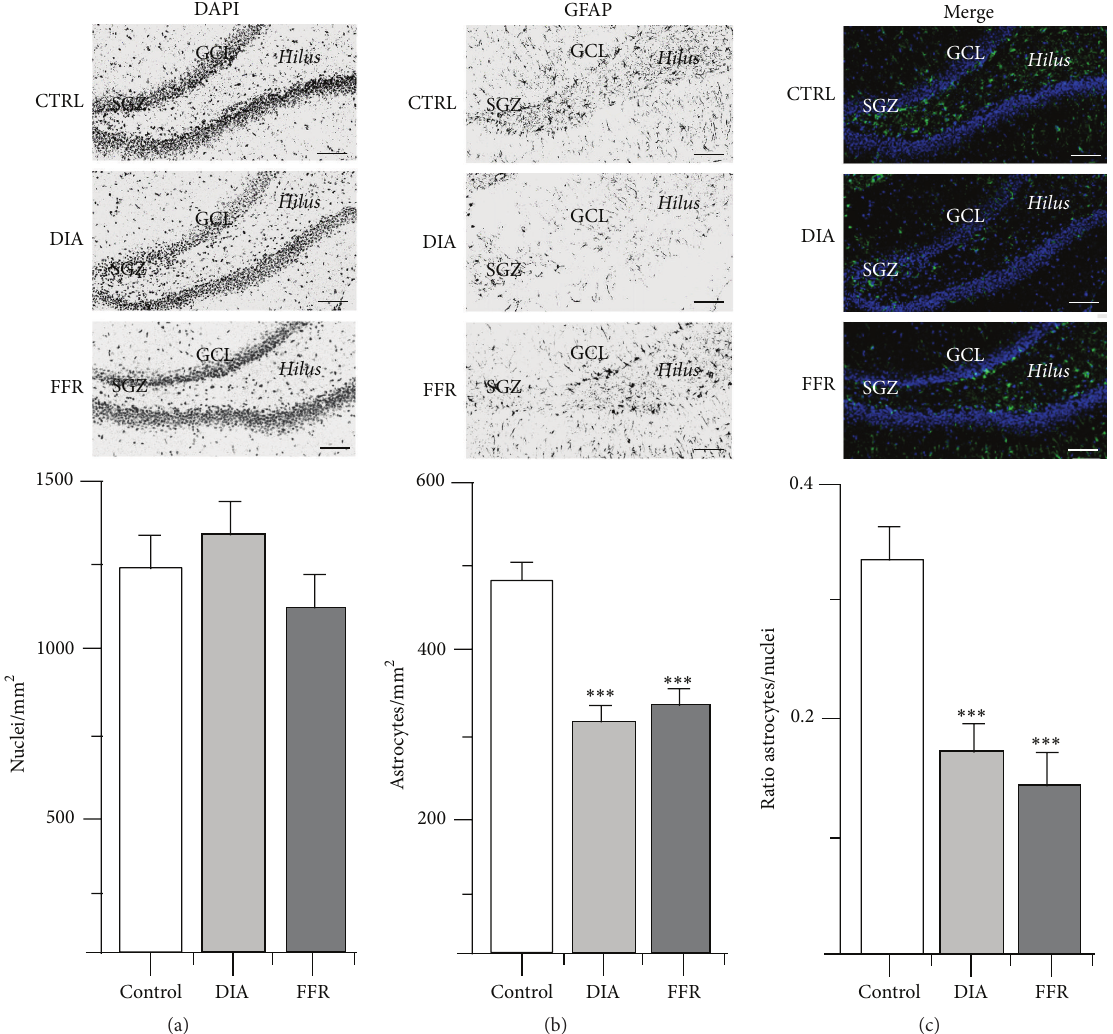
Figure 5: Effect of dehydration-induced anorexia (DIA) on astrocyte density of hippocampal dentate gyrus (DG). Coronal sections of the hippocampus show DAPI (a) or GFAP immunostaining (b). The overlay of DAPI and GFAP is also shown for the control, DIA, and forced food-restricted (FFR) groups (c). The density of nuclei did not differ significantly among experimental groups ( 𝑝 = 0.398 ). However, a significant reduction was observed forGFAP+ cell density and theastrocyte/nuclei ratio ( 𝑝 < 0.001 and 𝑝 < 0.001 , resp.) (seeTable 1). Nuclear and astrocyte densities were estimated in the hilus; subgranular zone (SGZ) and granular cell layer (GCL) are indicated as an anatomical reference. Scale bar = 50 𝜇 m. Data are expressed as mean ±